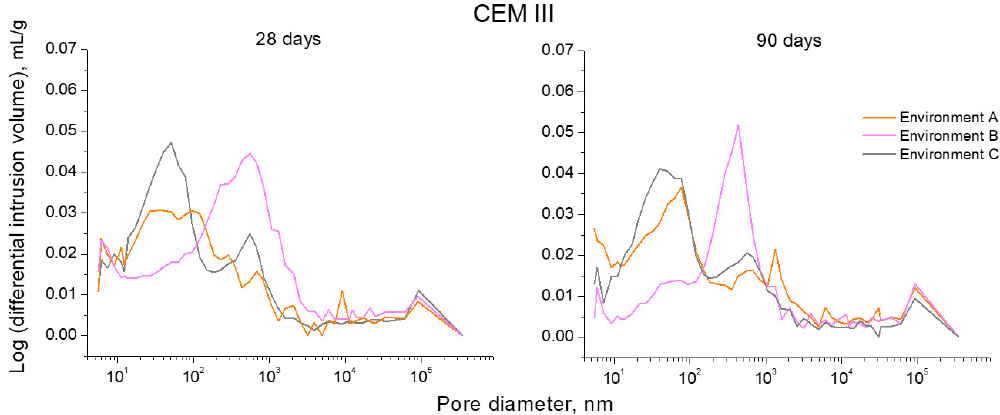
Figure 10. Curves logarithm of differential intrusion volume versus pore size obtained at 28 and 90 hardening days for CEM III mortars exposed to the three studied environments.